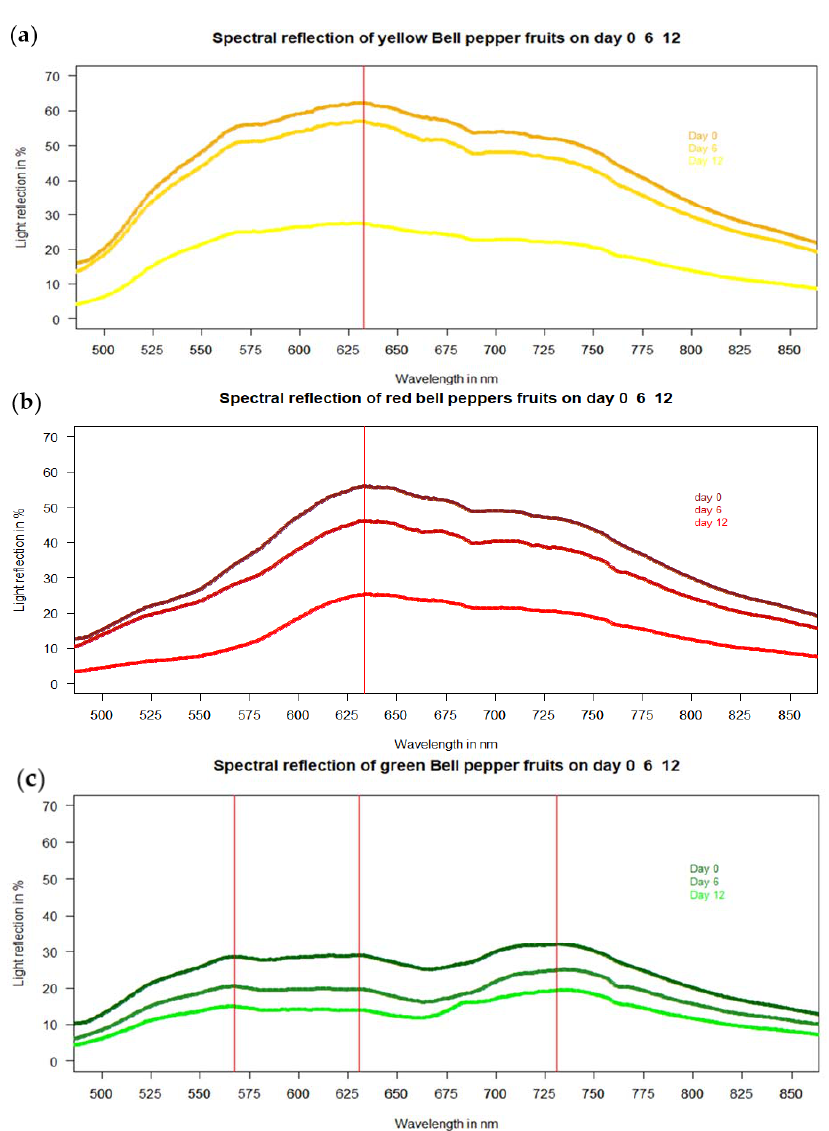
Figure 9. Percentage spectral light reflection of ( a ) yellow, ( b ) red, and ( c ) green bell pepper fruits in three stages of freshness (shriveling and storage day 0 = fresh fruit, day 6 = d.o.s 2, day 12 = d.o.s 4) (barium sulfate = 100% light reflectance) (n = 20 fruit per color, i.e., per curve; n = 60 overall). Freshness may be parametrized by the universal reflectance peak at 630–633 nm and reflectance at 500 nm (formula (3)). With fresh red pepper fruit, the di ff erence in reflectance between 630 nm and 500 nm is 40.4%, declined to 32.0% with 6-day old peppers (shriveling degree-d.o.s. 2) and finally to ca. 20.7% with 12-day old fruits (shriveling degree-d.o.s. 4) (Table 2). Table 2. Freshness index ( = di ff erence between light reflection at 630 nm and 500 nm) Colour of Bell Pepper Day 0 (Fresh) Day 6 (d.o.s.